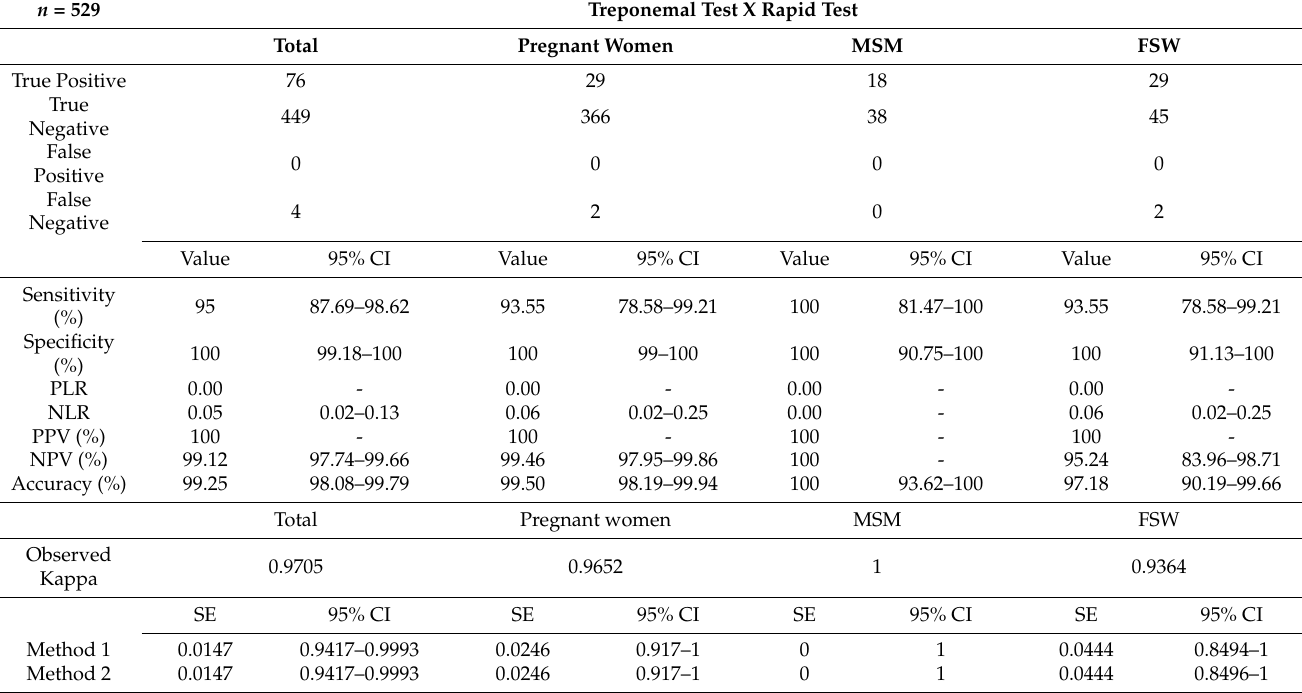
Table 1. Concordance performance of the rapid Duo test with the reference test for